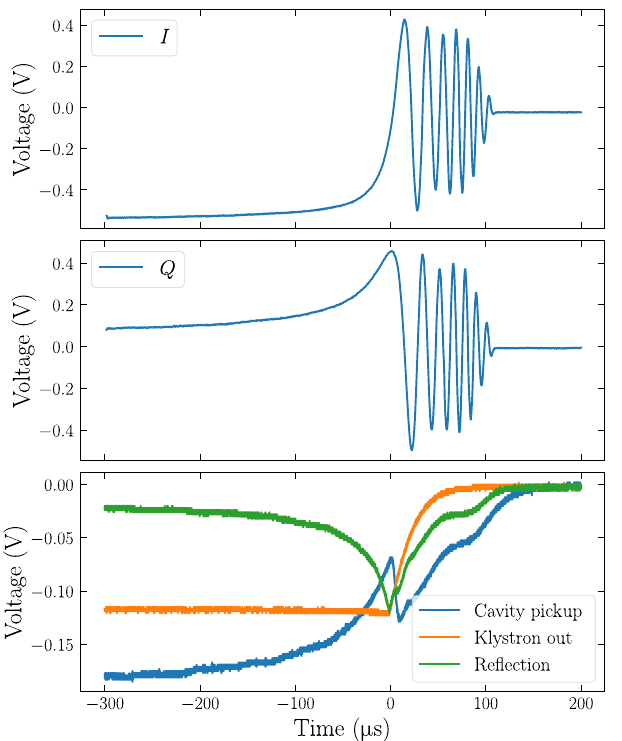
FIG. 6. The I and Q components of the beam signal after offline low-pass-filter processing. In the lowest frame, the detected signals of the cavity pickup, klystron output, and reflected rf from the cavity are indicated, where all signals have negative polarity. At the time t ¼ 0 , the rf power to the cavities was cut off due to the beam dump.